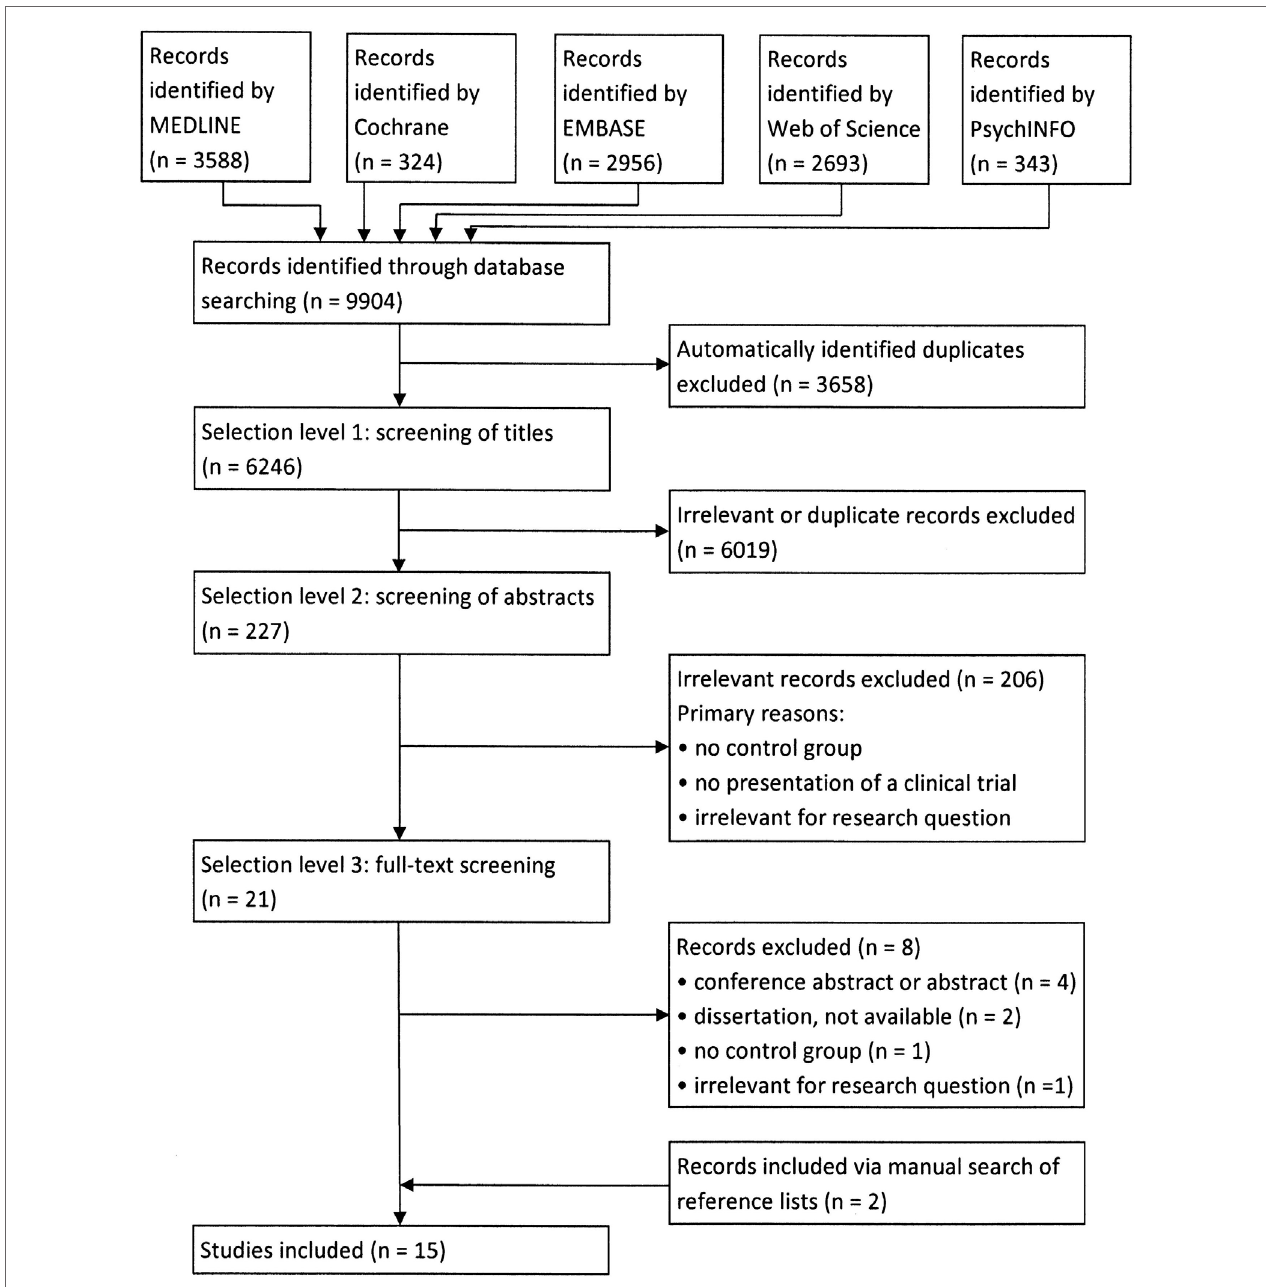
FiGURe 1 | Literature search flowchart